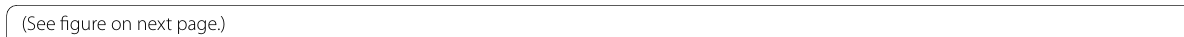
figure on next Fig. 4 Follow-up outcome of 47-year-old female with incidentally detected anterior mediastinal lesion who underwent chest MRI. On chest MRI, a 19 mm unilocular and ovoid anterior mediastinal lesion shows both high signal intensity on coronal T2 (arrowhead, a ) and pre-contrast T1-weighted images (arrowhead, b ) and no remarkable enhancement on post-contrast T1-weighted image (arrowhead, c ). Patient underwent annual follow-up for the anterior mediastinal lesion. Compared to the baseline non-contrast coronal chest CT image (arrowhead, d ), the lesion size increase from 15 to 25 mm on follow-up coronal contrast-enhanced chest CT image after 3 years (arrowhead, e ). Patient underwent thymectomy, and the gross pathology shows a 25-mm well-defined ovoid cyst with cystic content of mucinous material ( f ). The pathologic diagnosis was a thymic